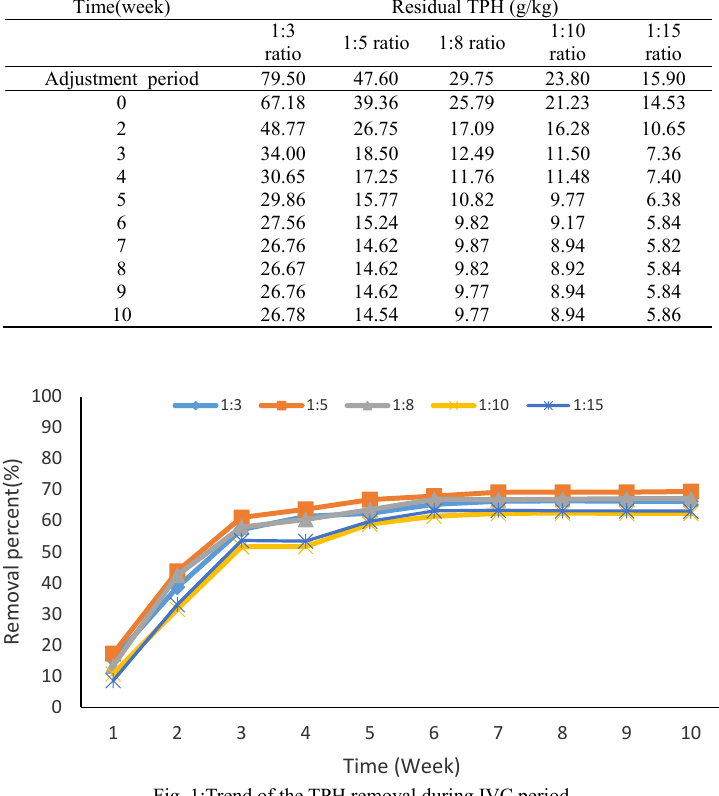
Fig. 1:Trend of the TPH removal during IVC period